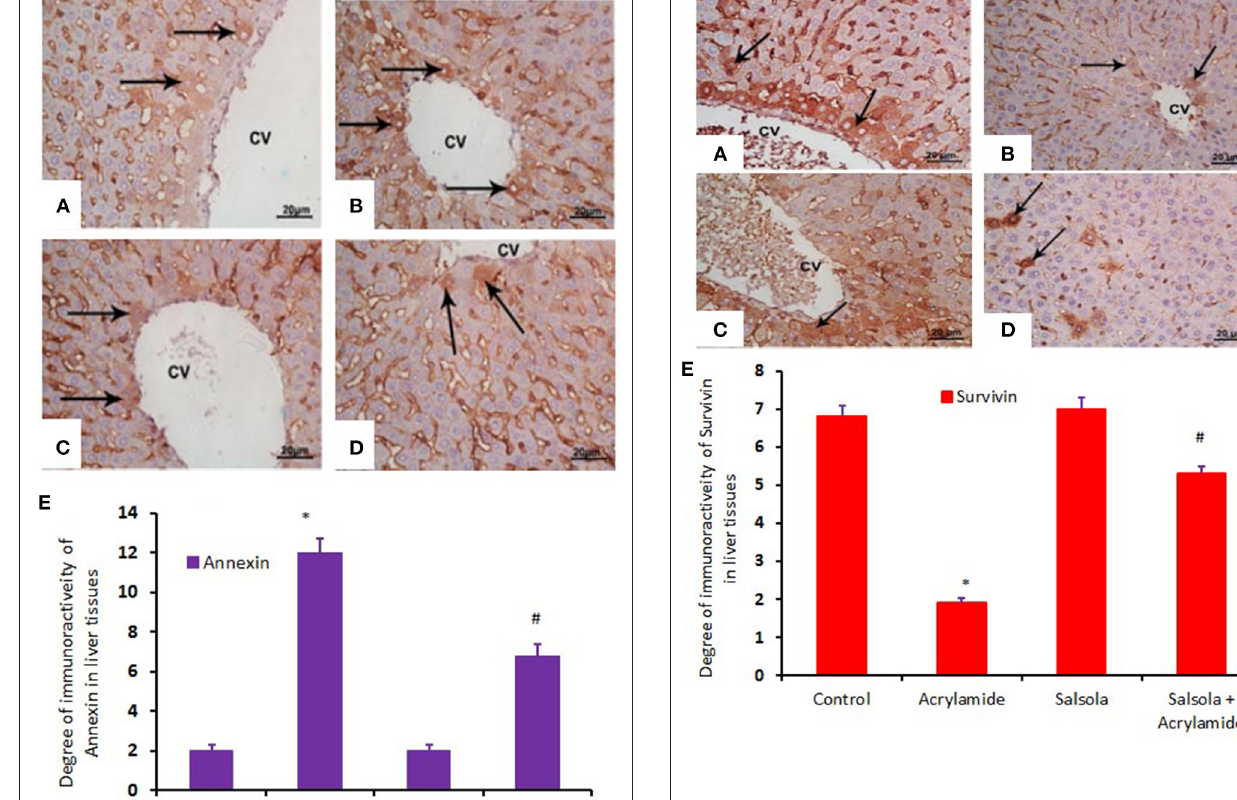
FIGURE 9 | Photomicrographs of hepatic sections immunostained with survivin antibody, in the control group (A) , the Salsola -treated group (C) , the acrylamide-treated group (B) , and the group co-treated with Salsola and acrylamide (D) . The intensity of immunostaining was high in the control and Salsola -treated groups (A,C) , reduced in the acrylamide-treated group (B) , and restored to moderate levels in the co-treated rats (D) . Reactive liver cells (arrows) are usually next to central veins (CVs). Scale bar = 20 µ m (original magnification = 200 × ). The degree of positive immunoreactivity for survivin is graphed in (E) . Densitometric values are statistically significant at * p < 0.05 vs. the control and Salsola -treated groups; # p < 0.05 vs. the acrylamide-administered